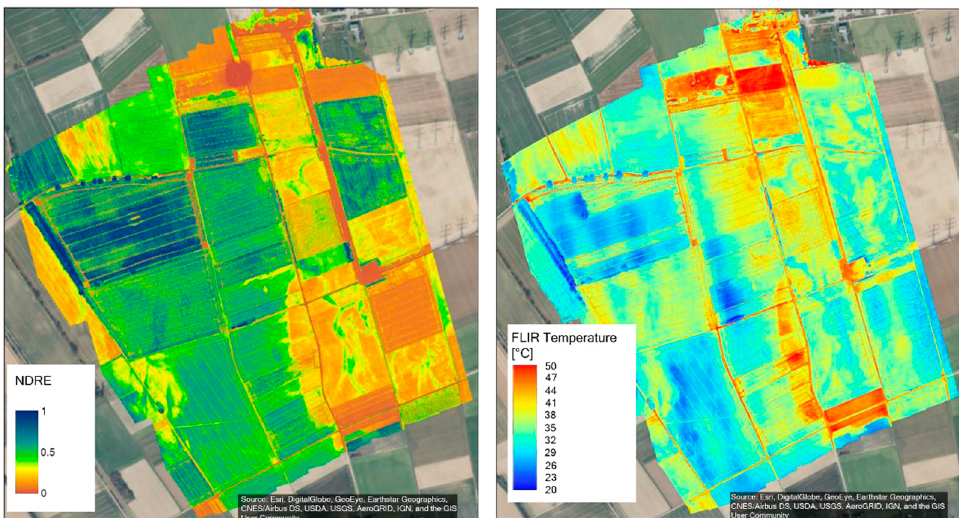
Figure 5. Normalized Difference Red-Edge (NDRE) index measured by the Micasense RedEdge-M multispectral sensor (left) and surface temperature ( ◦ C) measured by the FLIR VUE Pro 640 thermal infrared camera (right) on the 27 June 2019. Table 3. Spectral band information for the Micasense RedEdge-M.